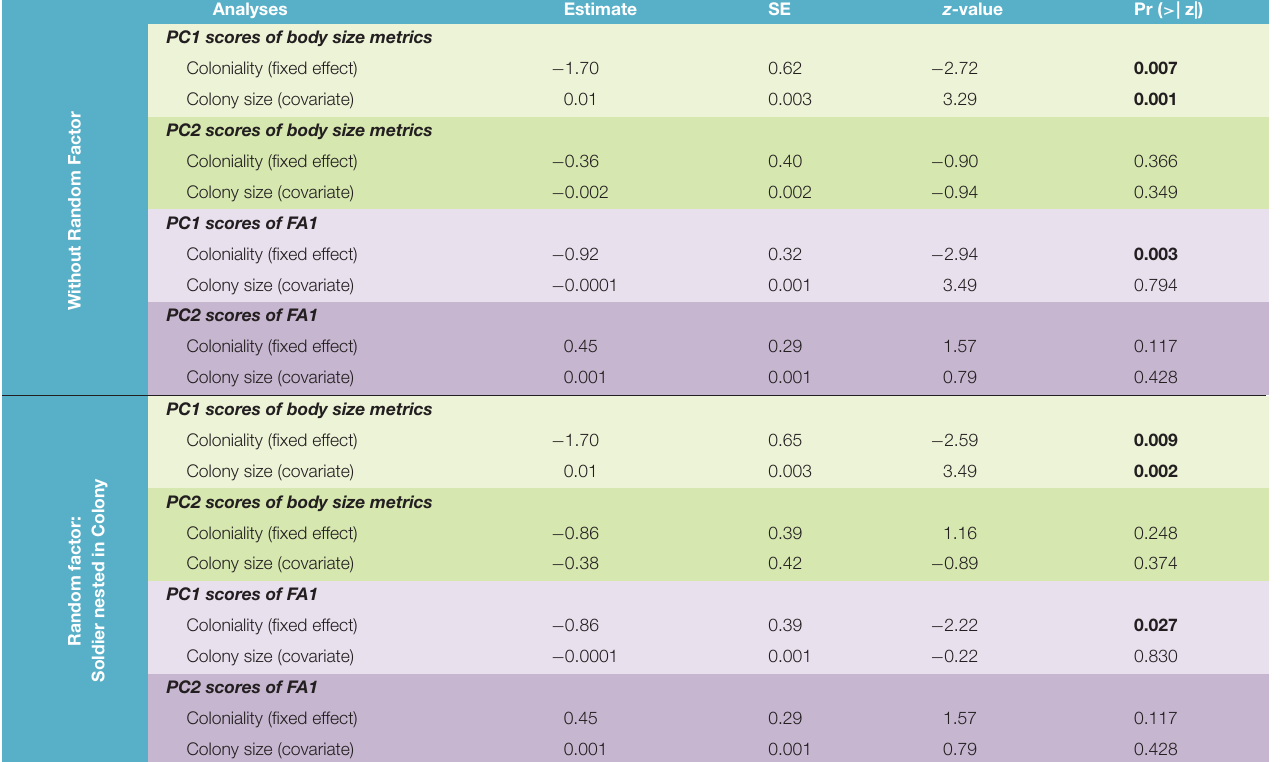
TABLE 2 | Fixed effects of the GLMM analyses for body size metrics (green shadow) and fluctuating asymmetric indexes 1 (FA1) (purple shadow) of soldiers of N. chilensis from multicolonial and unicolonial substrates.